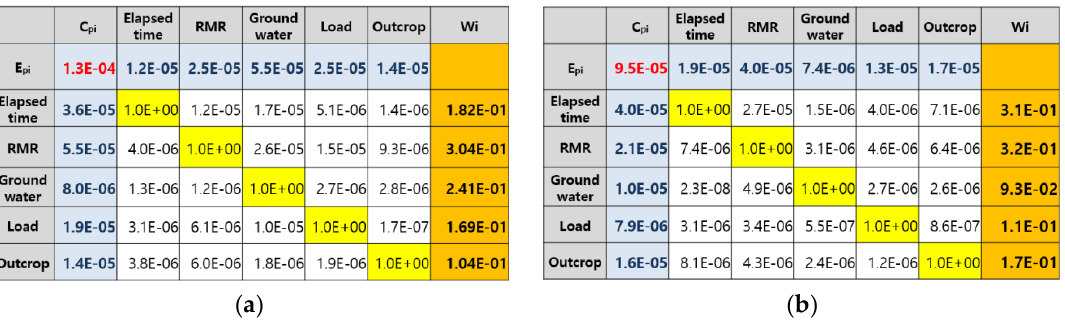
Figure 13. Interaction matrix for ( a ) coal mines and ( b ) other types of mines.